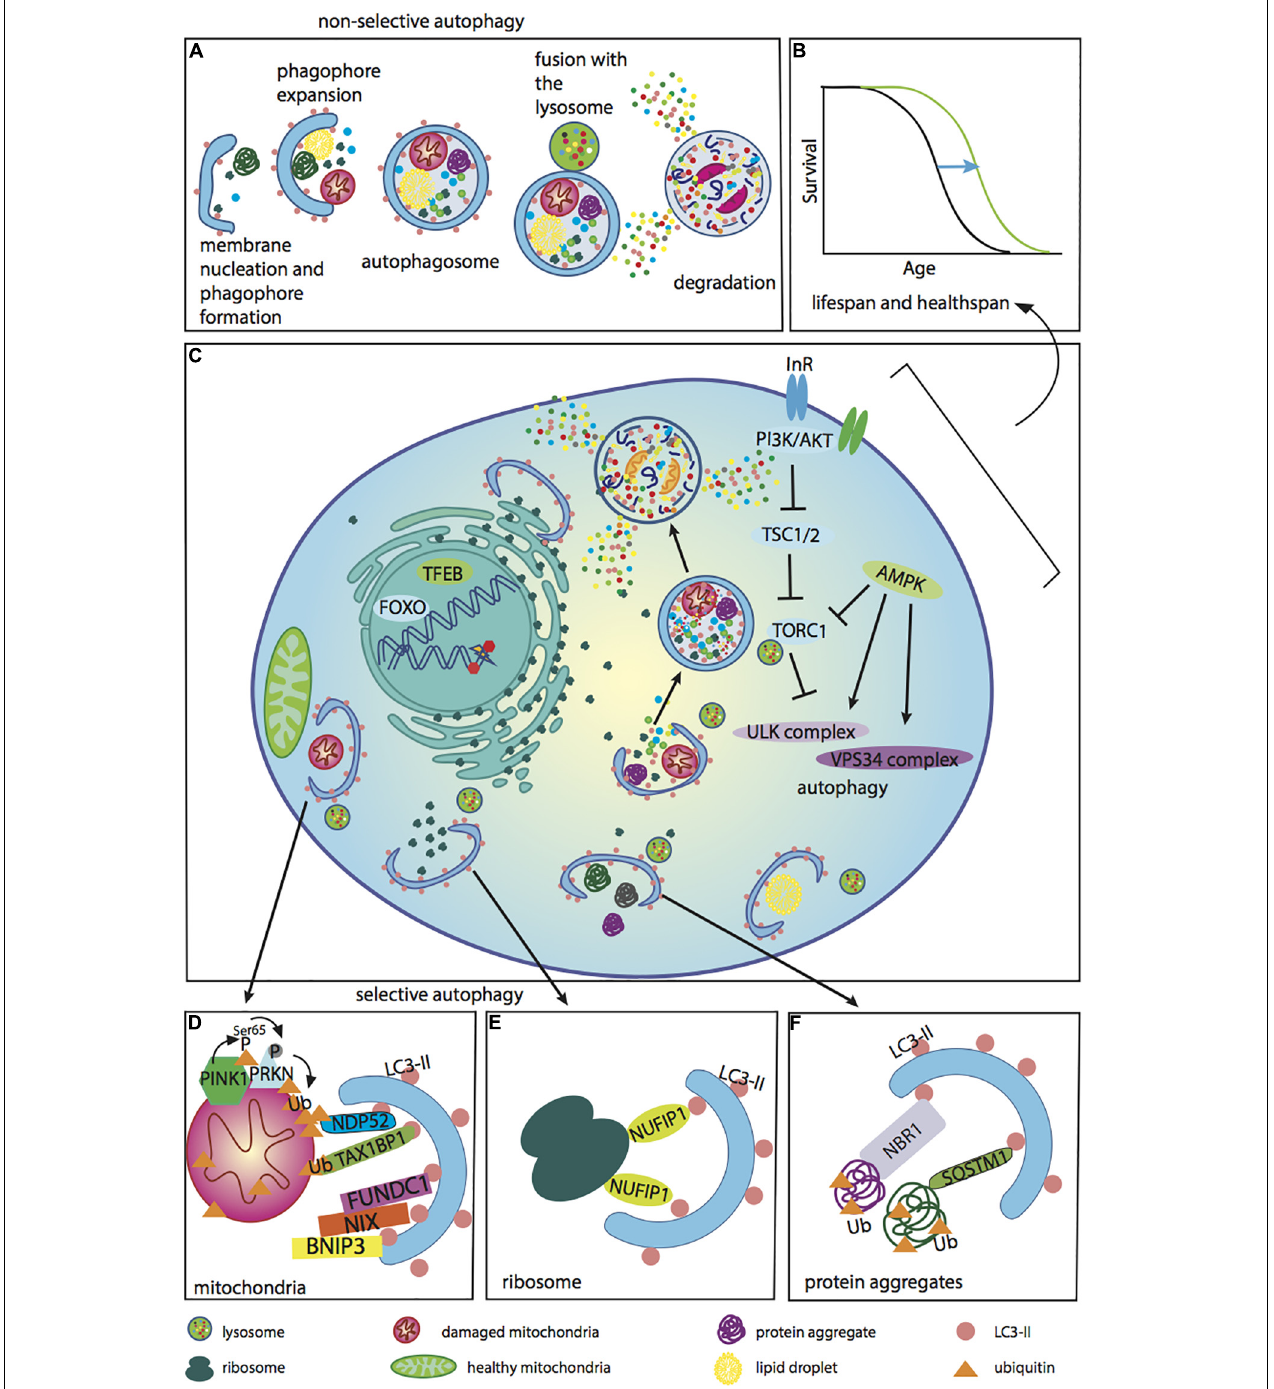
FIGURE 1 | Autophagy regulators and functions associated with anti-aging effects. Different cellular components can be degraded by either non-selective or selective autophagy. These forms of autophagy are regulated by PI3K, mTOR, and AMPK, as well as the transcription factors TFEB and FOXO, which are accountable for the transcription of many genes involved in the autophagy process. (A) The different steps of non-selective autophagy. Upon autophagy initiation, a phagophore is formed and expanded, thereby producing an autophagosome. The matured phagosome fuses with the lysosome, initiating degradation of the autophagosome’s inner membrane. Cellular components captured within are subsequently degraded and released into the cytoplasm. Autophagy occurs under basal conditions in the cell, but can be up-regulated during stress. The autophagy process is inefficient during aging. (B) A lifespan curve illustrating the positive effects of enhancing autophagy during aging to improve the recycling of different cellular components, extending lifespan and healthspan. Anti-aging effects of autophagy up-regulation have been demonstrated in several model organisms. It has been shown in a number of studies that the lifespan of long-lived mutants is